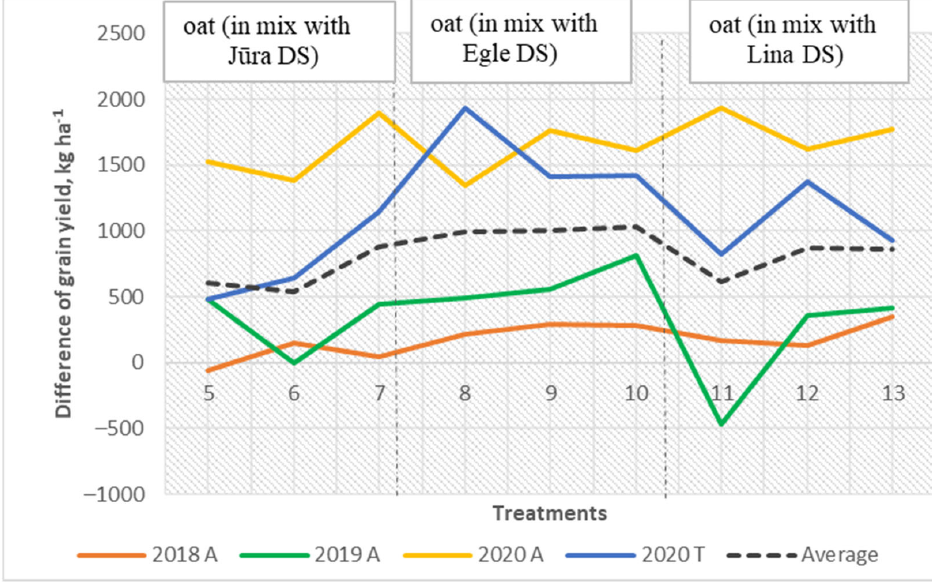
Figure 6. The grain yield of oat in the mixtures: difference between actual and expected grain